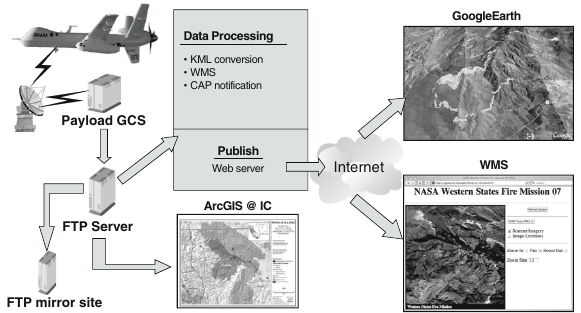
Figure 7. Data collection and distribution of sensor data, illustrating the Web Services employed in the generation and Figure 4. Data collection and distribution of sensor data by distribution of the AMS sensor data sets. The AMS-derived products, generated onboard the Ikhana UAS, transmitted to the Payload Ground Control System (GCS), and then to the NASA FTP server are processed into a variety of prod- Web Services for Ikhana fire observations UAS (Ambrosia) uct formats including Keyhole Markup Language (KML) Google Earth–enabled formats, Web Map Service (WMS) format, and as a Common Alerting Protocol (CAP) notification. Data investigators can also access AMS-derived product data (fire hot spot shape files) from the NASA FTP server (or a mirrored site at USFS) using Geographic Information Systems (GIS) software, such as ESRI’s ArcGIS package.